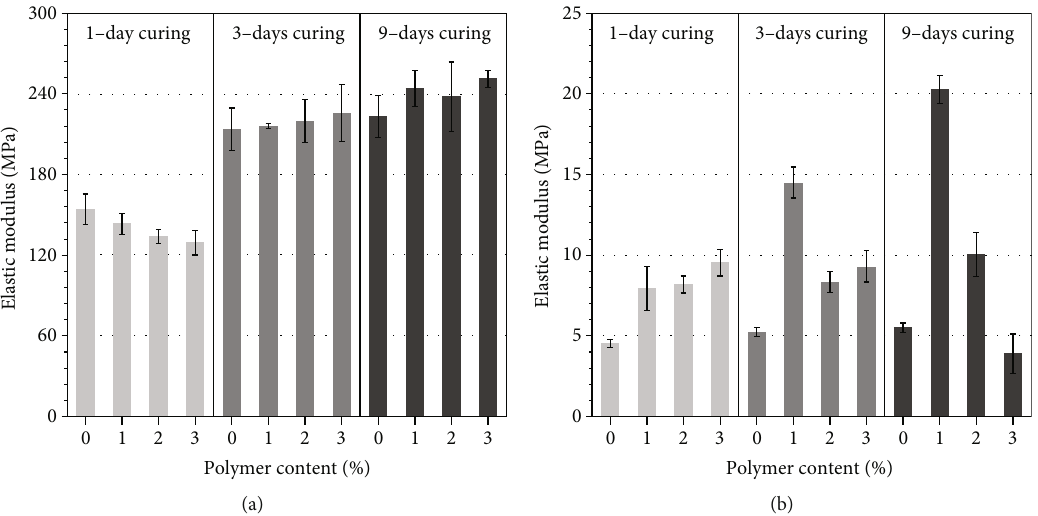
Figure 6: Variation of elastic modulus with polymer content and curing time. (a) Specimens cured in room condition and (b) specimens cured in optimum water content condition.